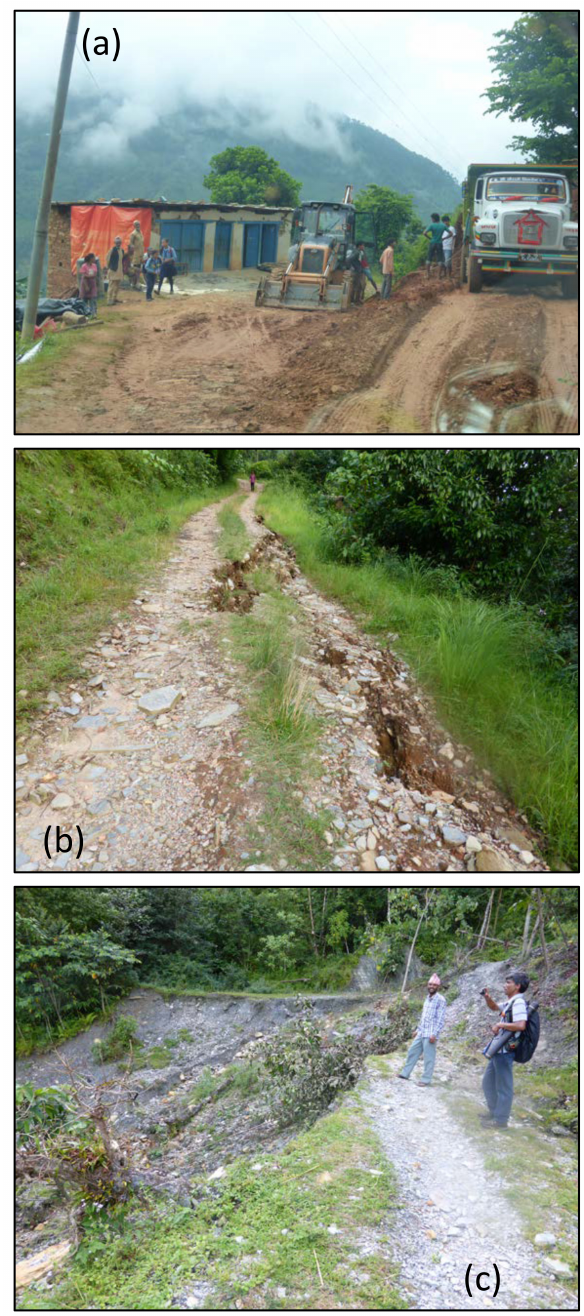
Figure 2. Informal, rural roads in Sindhupalchok District, Nepal. (a) Earth-moving equipment is hired by villagers to expand foot- paths into roads that bring goods and services to isolated locations. In (b) and (c) , landslides are triggered on these informally engi- neered rural roads. Poor drainage and lack of slope stabilizing mea- sures facilitate failures during heavy monsoonal rains, damaging land, structures, and roads, and endangering human lives and liveli- hoods. Images by the